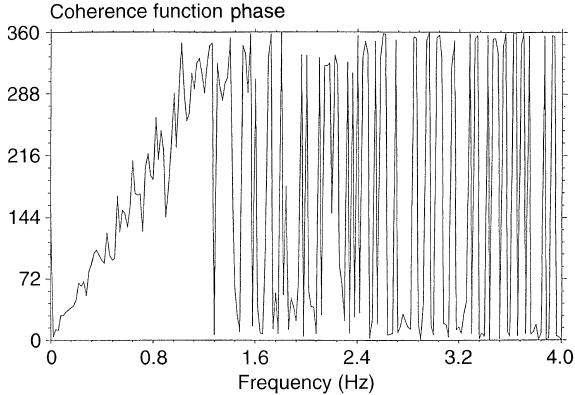
Fig. 5. Phase function calculated for B z components of AMPTE UKS and AMPTE IRM magnetic fields for the time interval 650– 1100 s. The units for y -axis of this plot are